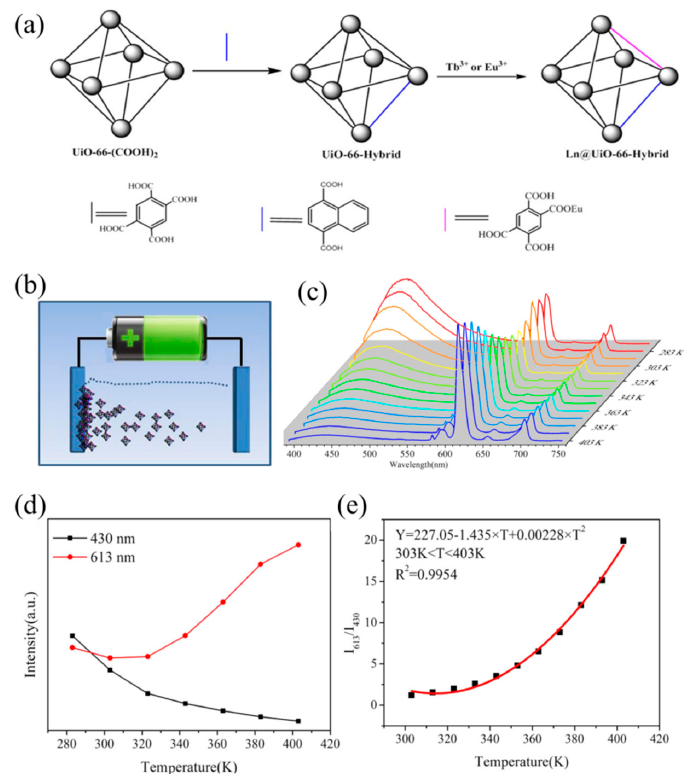
Figure 15. ( a ) Preparation of Ln@UiO-66-hybrid composition by post-synthetic exchange and post-synthetic modification; ( b ) Fabrication of composite films via electrophoretic deposition method; ( c ) Emission spectra of the Eu@UiO-66-hybrid in the temperature range of 273–403 K; ( d ) Emission intensities at 430 and 613 nm in the temperature range of 303–403 K; ( e ) Emission intensity ratio of the Eu@UiO-66-hybrid film as a function of temperature with the fitting curve. Reprinted with permission from Reference [75]. Copyright 2018 the American Chemical Society, (Washington, DC, USA).